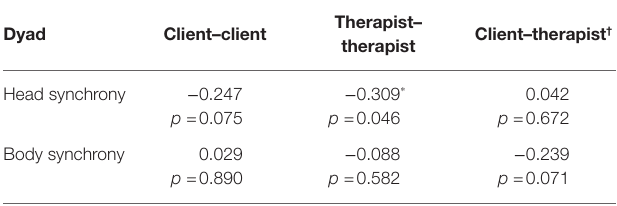
TABLE 3 | Estimates of the difference between synchrony in regular and measurement sessions.